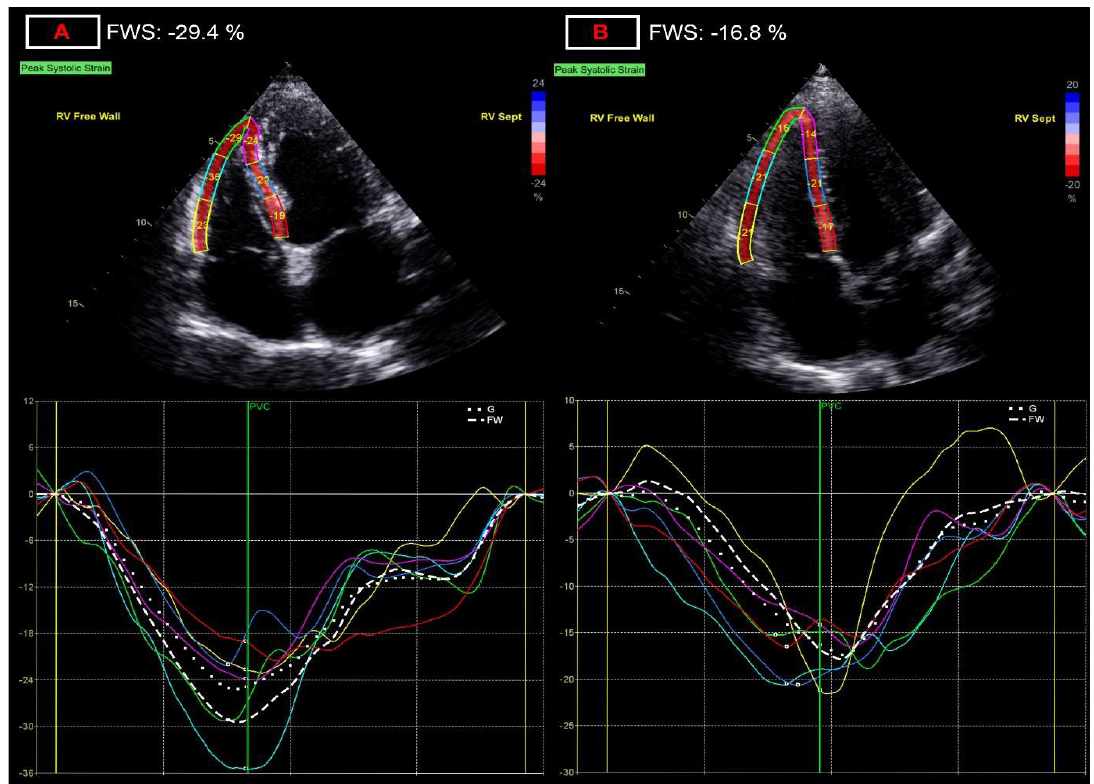
Figure 3. Representation of alterations of right ventricular free wall strain (FWS) measurement. ( A ) panel: normal right ventricular free wall strain of − 29.4%; ( B ) panel: decreased right ventricular free wall strain of − 16.8%, after COVID-19 infection.